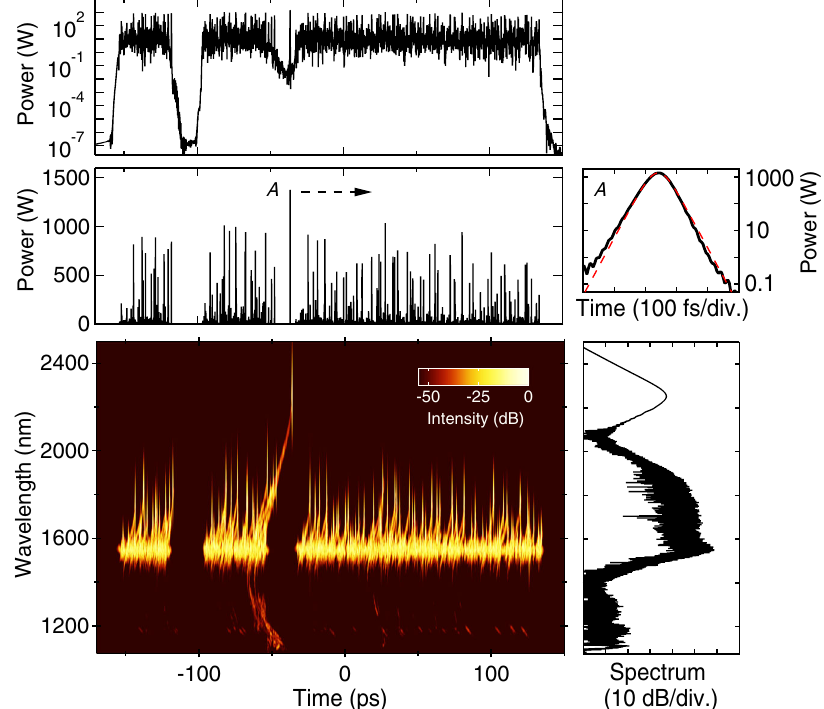
Fig. 3 Simulated single-shot spectrogram at the HNLF output. The spectrogram representation is shown together with the projected temporal intensity (top, shown on both linear and logarithmic scales) and spectrum (right). The highest temporal intensity peak from simulation ( A ) is shown in an expanded view on a logarithmic scale (black solid line) and compared with a hyperbolic secant soliton fi t (red dashed line). The Supplementary Movie shows the spectrogram evolution over one